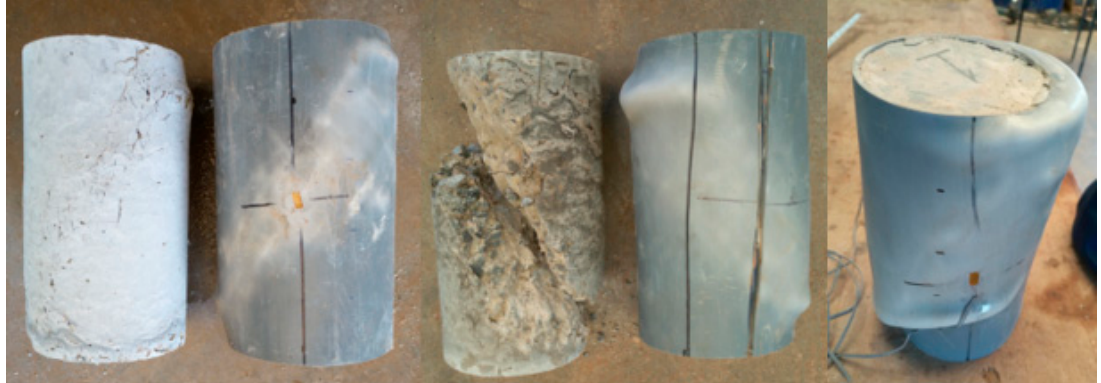
Figure 9. Shear Type Failure.